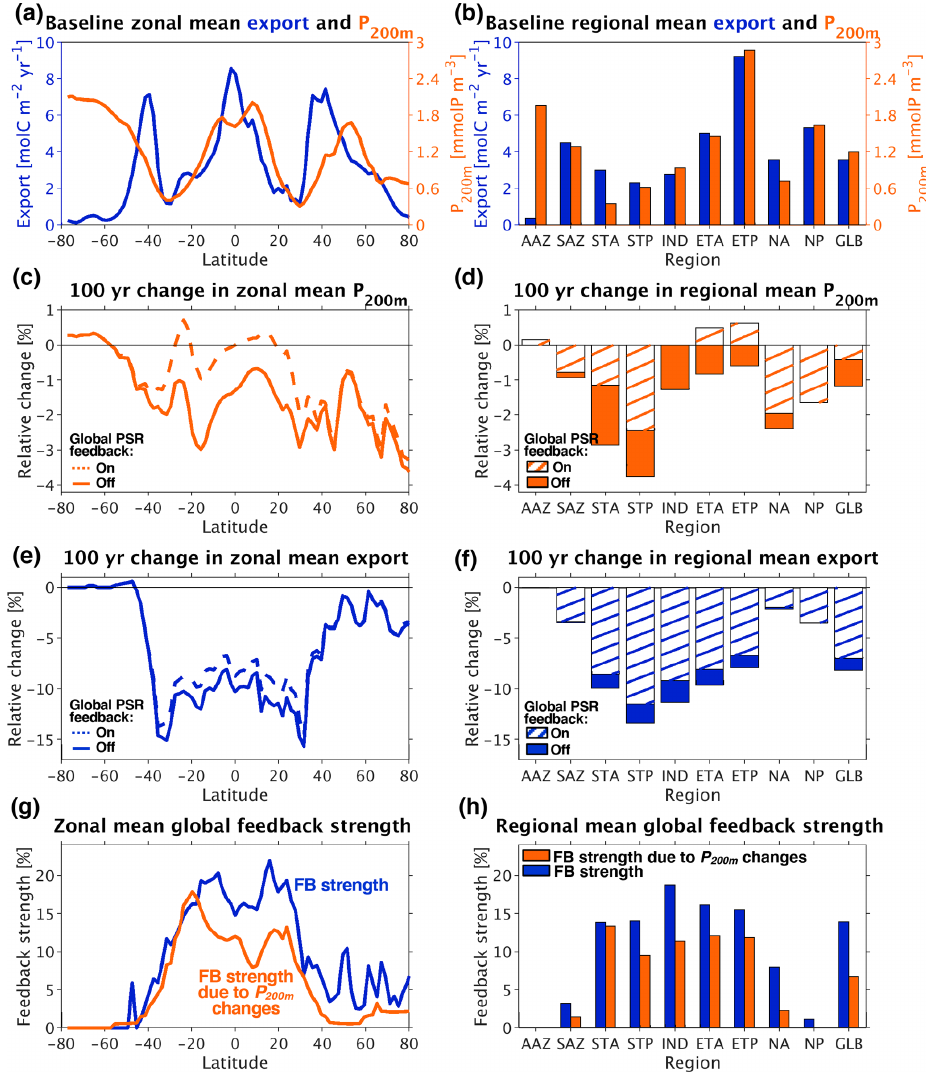
Figure 7. (a) Baseline (current-day circulation, ran to steady state) zonal mean export and shallow subsurface (200m) phosphate concentra- tion. (b) Same as (a) but with regional and global (GLB) rather than zonal means. (c) Relative changes (calculated as absolute changes from the baseline over the baseline mean) in zonal mean phosphate concentration at 200m depth 100 years after decreasing circulation rates by 10%. (d) Same as (c) but with regional and global means. (e) Relative changes in zonal mean export 100 years after decreasing circulation rates by 10%. (f) Same as (e) but with regional and global means. (g) Zonal mean PSR feedback (FB) strength, calculated as the difference in zonal mean export change from baseline between the feedback-off and feedback-on cases divided by the zonal mean export change in the feedback-off case alone (left-hand side of Eq. 4; shown in blue). Predicted zonal mean PSR feedback strength from changes in circulation and shallow subsurface phosphate concentration (right-hand side of Eq. (4); shown in orange). (h) Same as (g) but with regional and global